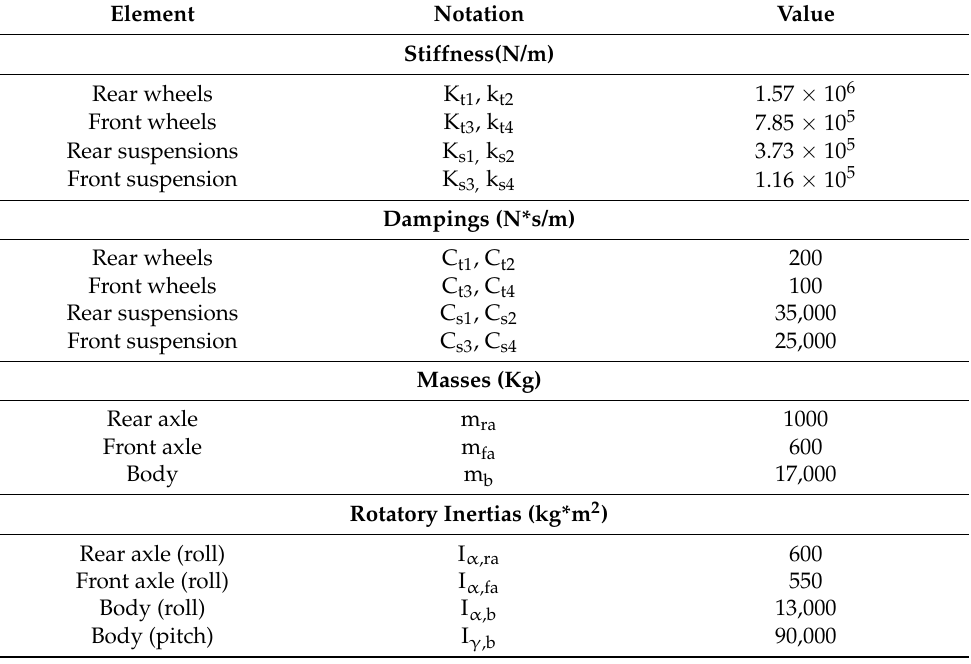
Table 4. The mechanical parameters of the vehicle.